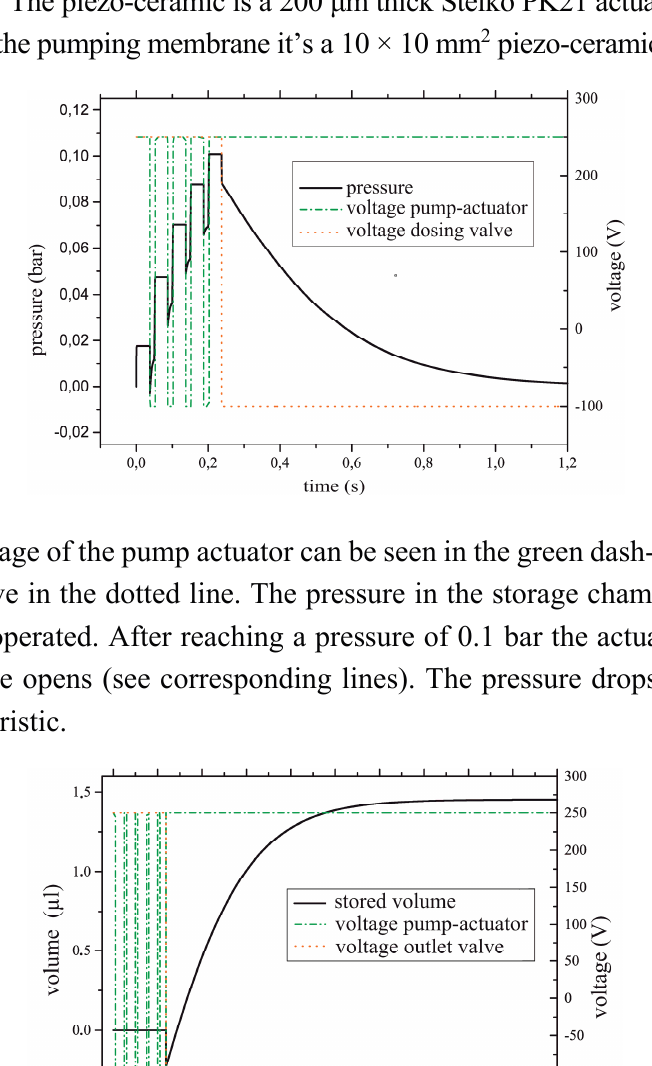
Figure 8. The values to be calculated, h v ( p , U ), C p and the center displacement, are shown in the schematic drawing. The piezo-ceramic is a 200 μ m thick Stelko PK21 actuator. For the valve a